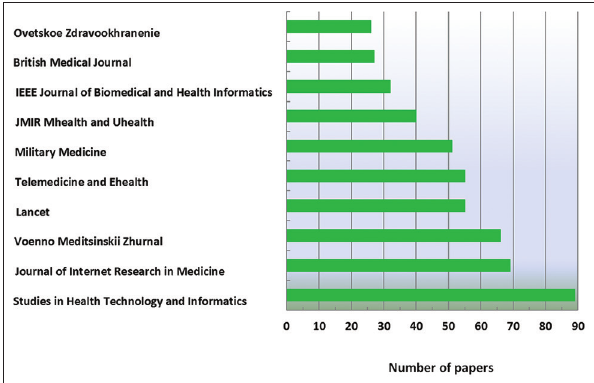
Figure-3: Top 10 productive journals in topic of mobile